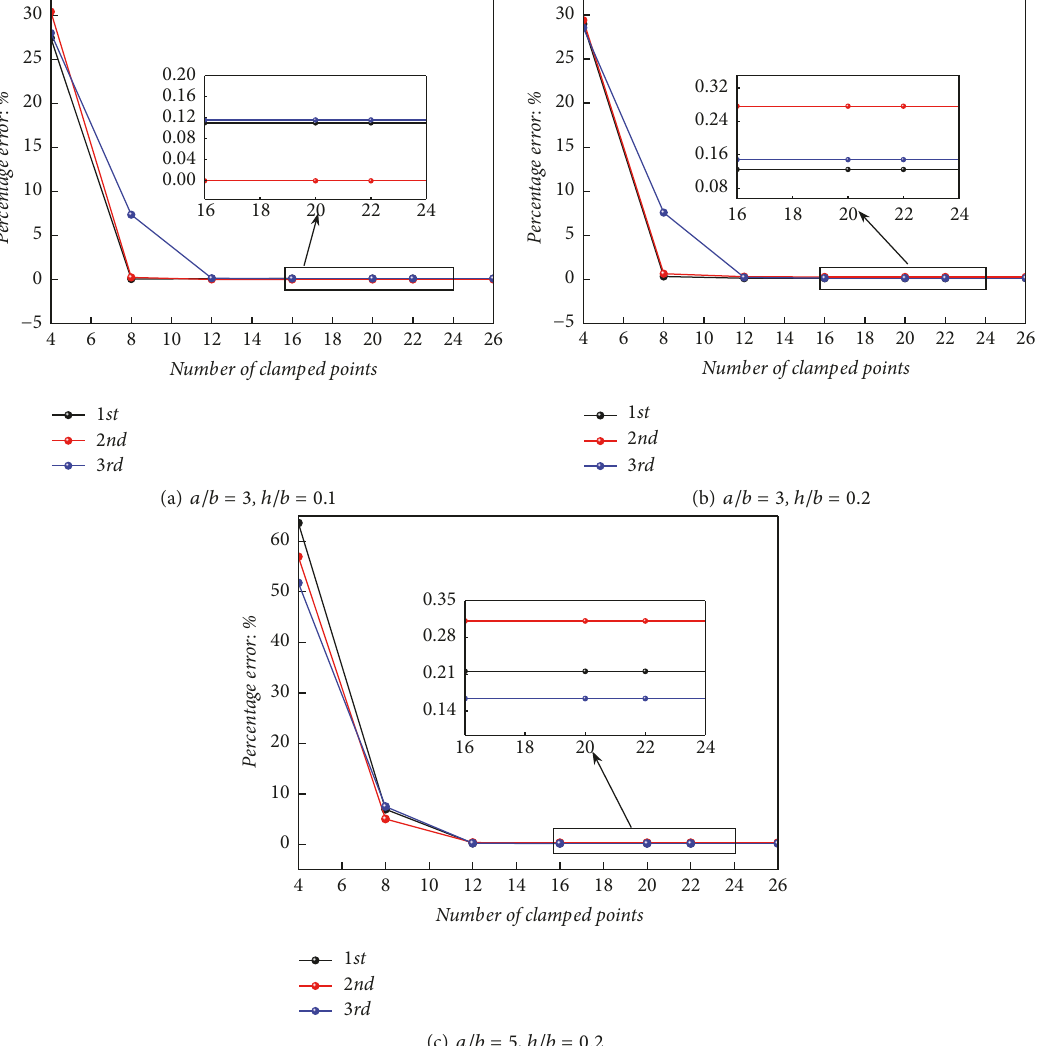
Figure 11: The discrepancy of nondimensional frequency parameters between different numbers of clamped points and clamped boundary condition ( 𝑏 = 1